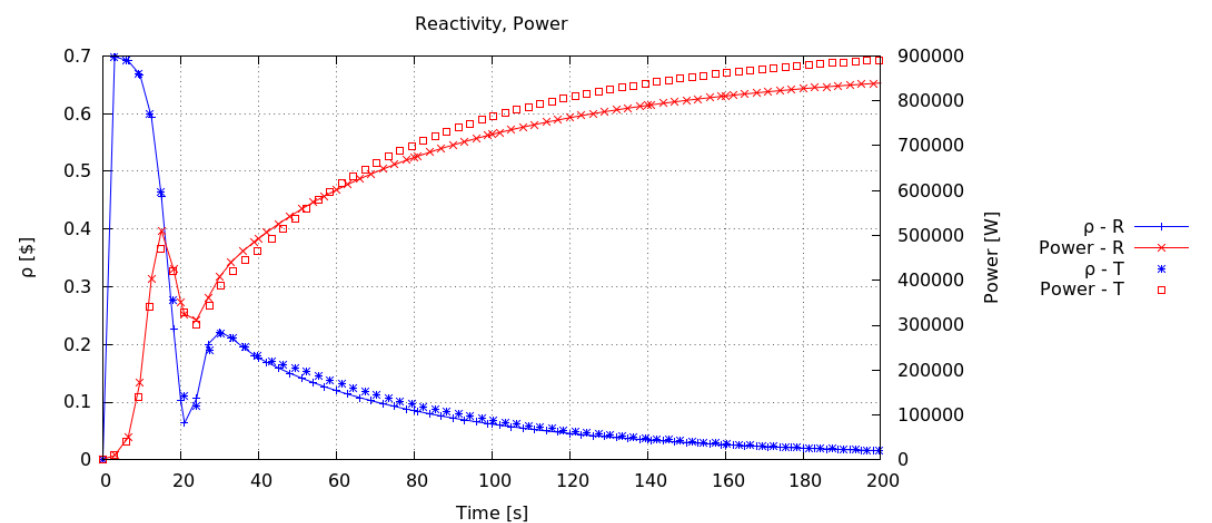
Figure 4. Reactor power and reactivity of system during step increase of reactivity accident by 0.7 β